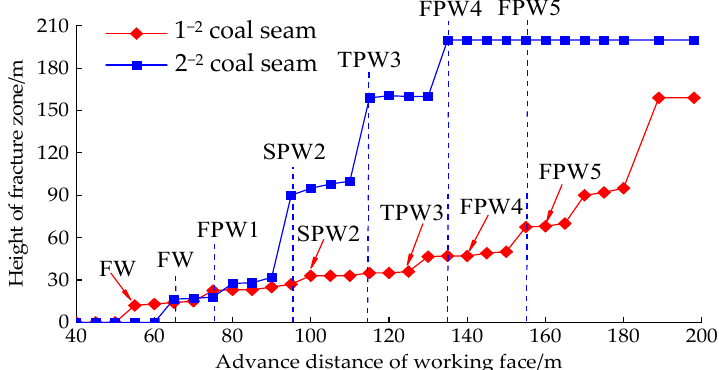
Figure 12. Height of overburden fractured zone after two coal seams mining.